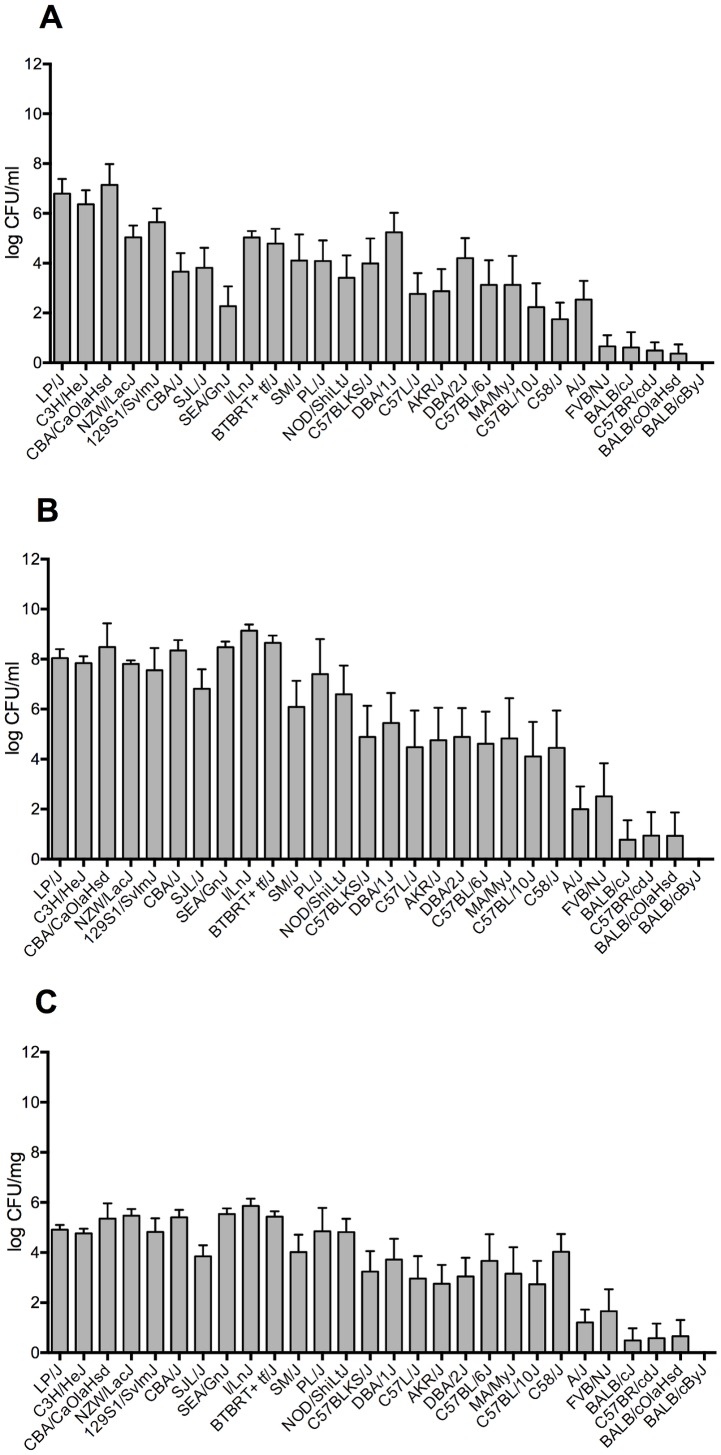
Bacterial counts in tissues of the tested inbred mice after intranasal-infection with S. pneumoniae, D39.Strains are ordered by increasing mean survival time post-infection. A) Bacterial count in blood 24 h post-infection B) Bacterial count in blood at the time of death C) Bacterial count in lungs at the time of death. Results are for a group of 10 animals. Error bar shows standard error (SE).